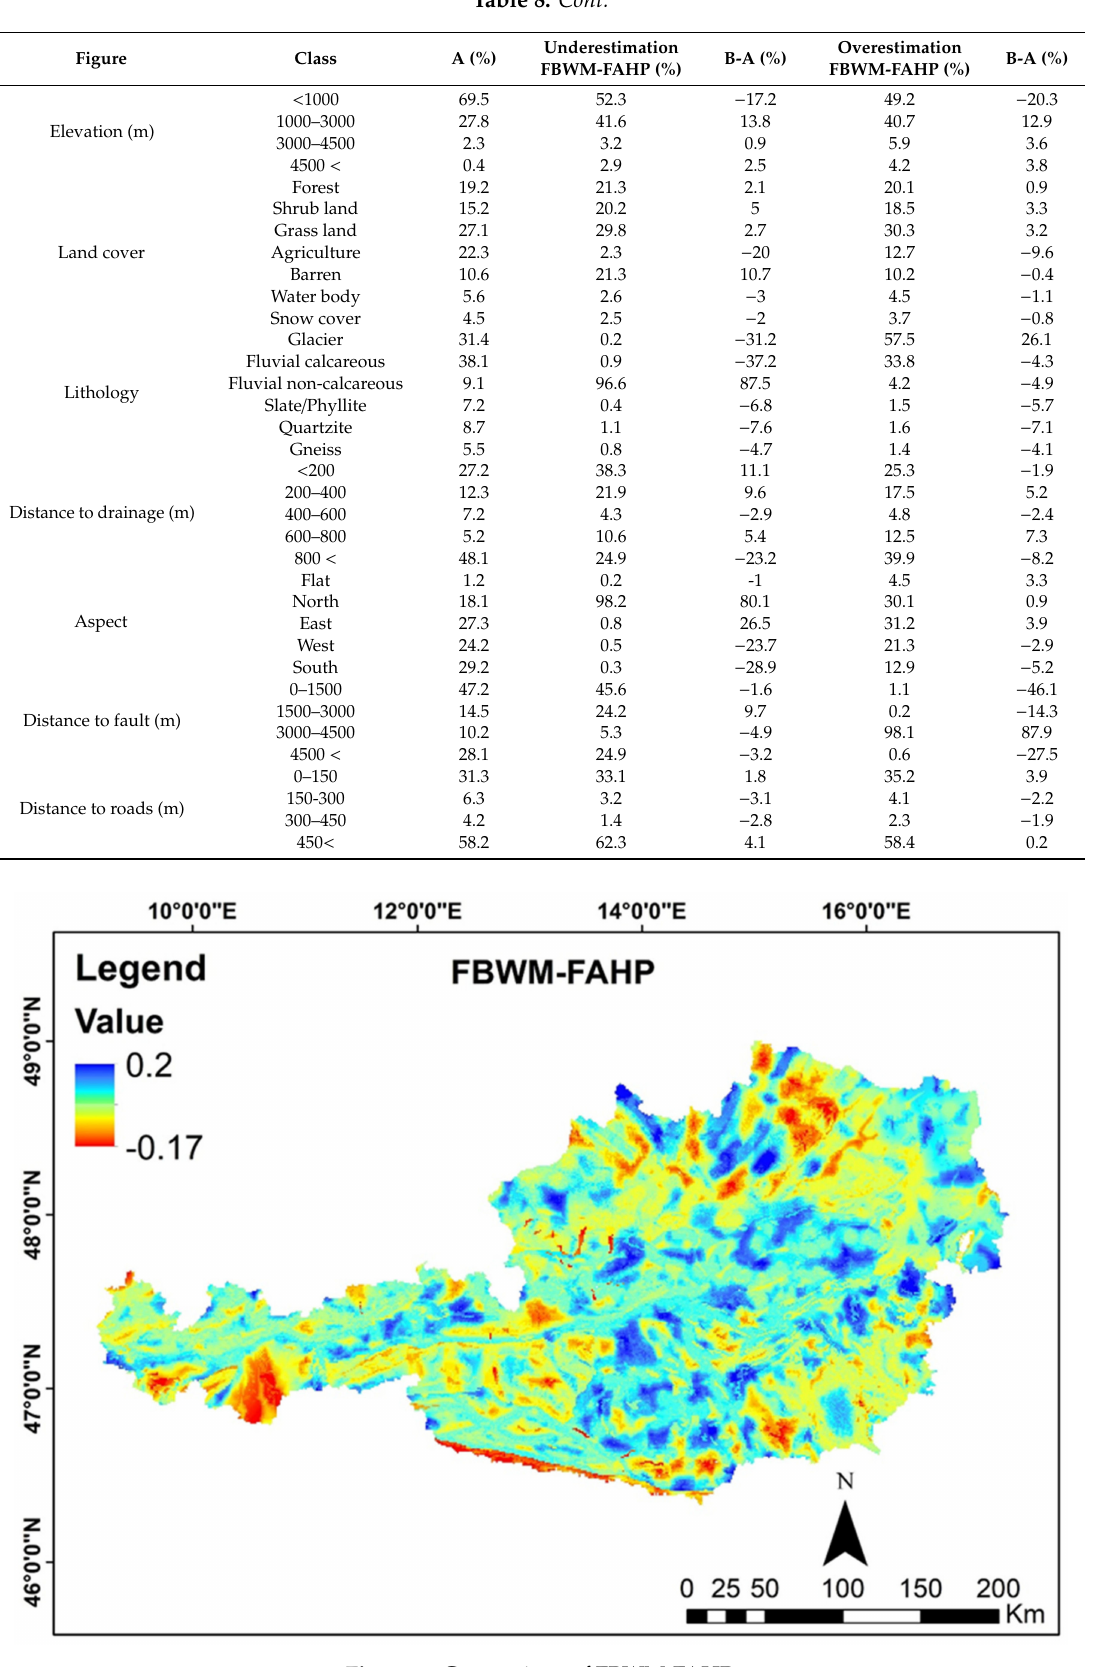
Figure 7. Comparison of